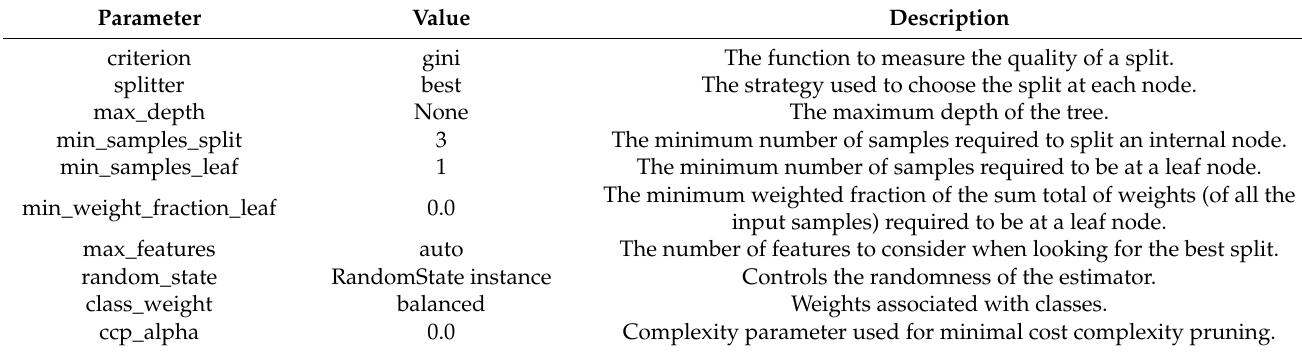
Table 6. Decision tree algorithm parameters [59].